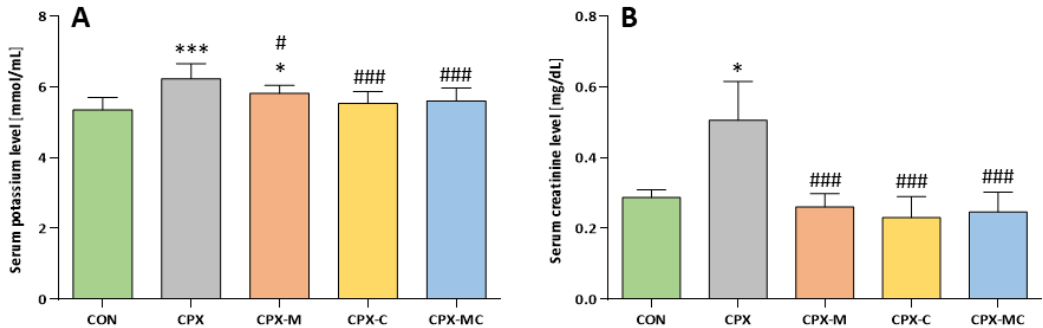
Figure 2. Serum potassium ( A ) and creatinine ( B ) levels on day 4 of the study. Data are presented as means ± SD. A detailed description of experimental groups is presented in Figure 1 and the Materials and Methods section. * p < 0.05, *** p < 0.001 vs. CON group; # p < 0.05, ### p < 0.001 vs. CPX group.